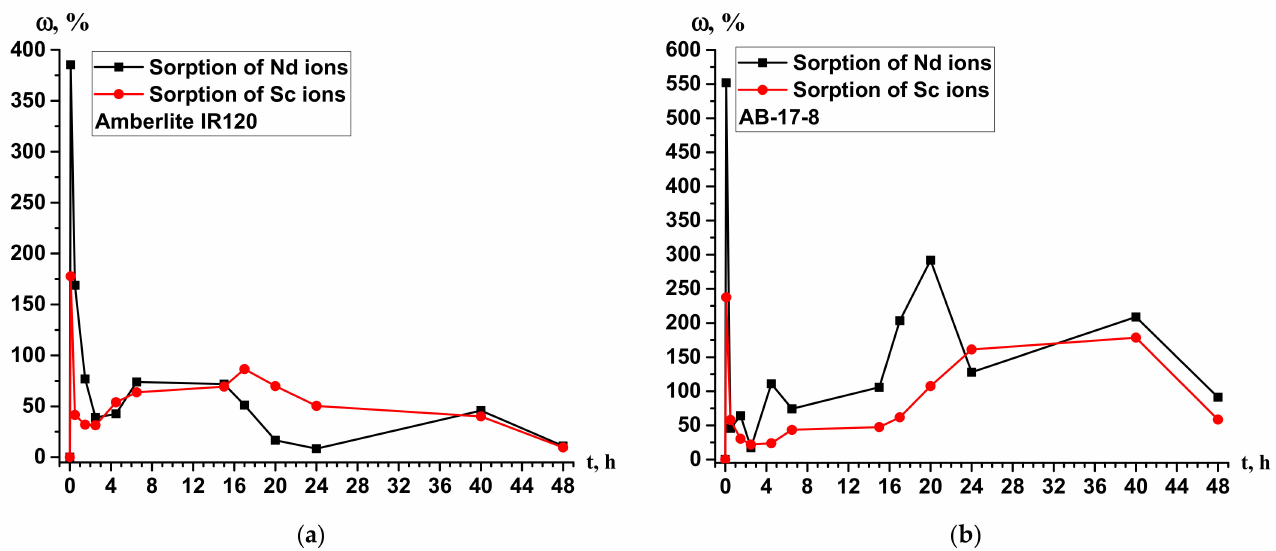
Figure 8. Average growth of sorption properties of Amberlite IR120 ( a ) and AB-17-8 ( b ) during Nd 3+ and Sc 3+ ions